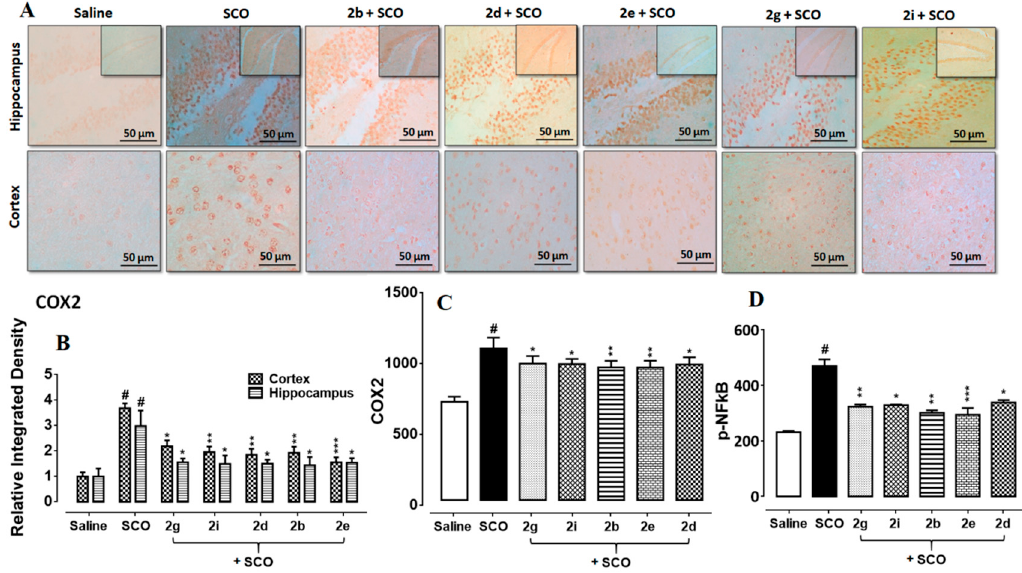
Figure 8. ( A , B ) Immunohistochemistry results for COX2 in the cortex and hippocampus (dentate gyrus, dg). Bar 50 µ m, magnification 40 × ( n = 5). Histograms show a comparatively higher expression of COX2 in the scopolamine group. ***, ** and * show p < 0.001, p < 0.01, and p < 0.05, respectively, and illustrate significant variation relative to scopolamine, while ### p < 0.001 shows significant variation relative to saline control group. Results are expressed as mean ± SEM. ( C ) The protein expression of COX2 quantified through ELISA. The data is presented as mean ± SEM. * p < 0.05 relative to scopolamine, while # p < 0.05 and ## p < 0.01 relative to saline control group ( n = 5). ( D )The protein expression of p-NFkB quantified through ELISA. The data is presented as mean ± SEM. * p < 0.05 relative to scopolamine, while # p < 0.05 and ## p < 0.01 relative to saline control group ( n = 5).